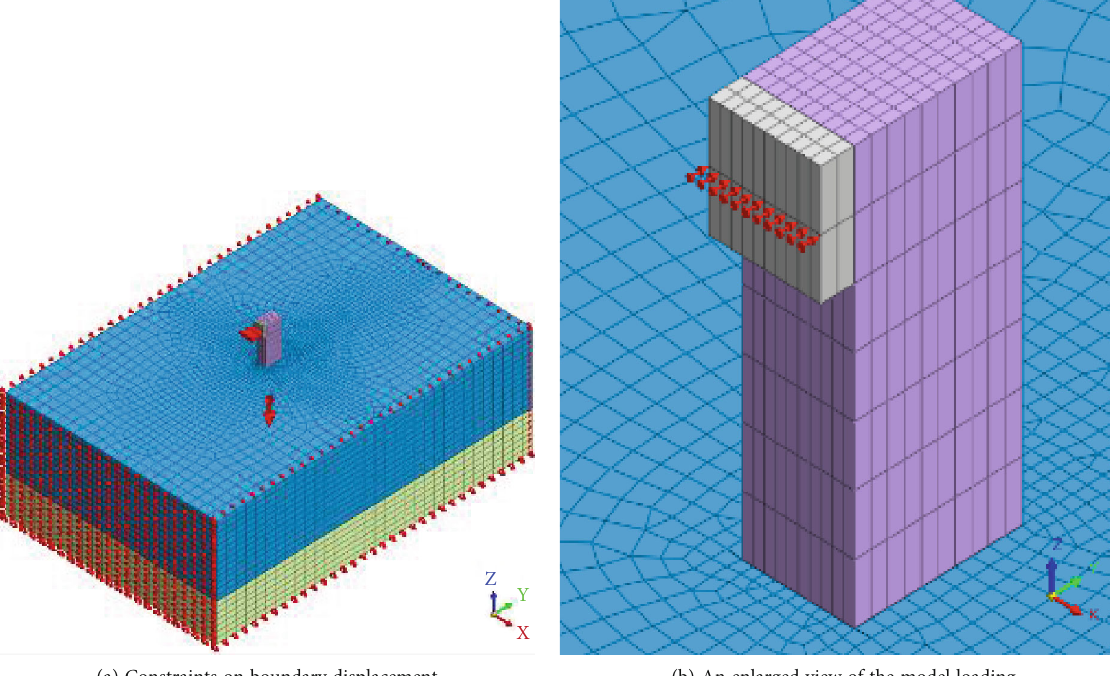
Figure 7: Boundary conditions and external loads.